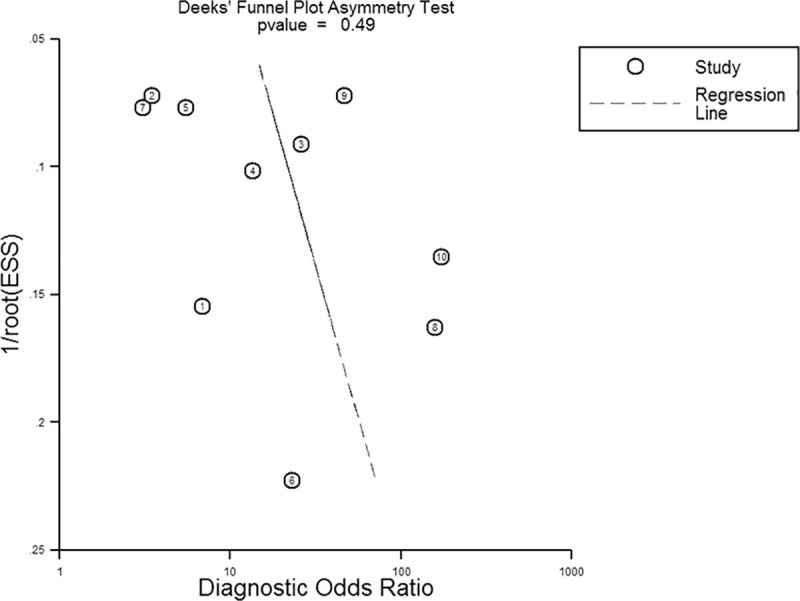
Deek’s funnel plot to assess publication bias.ESS, effective sample size.